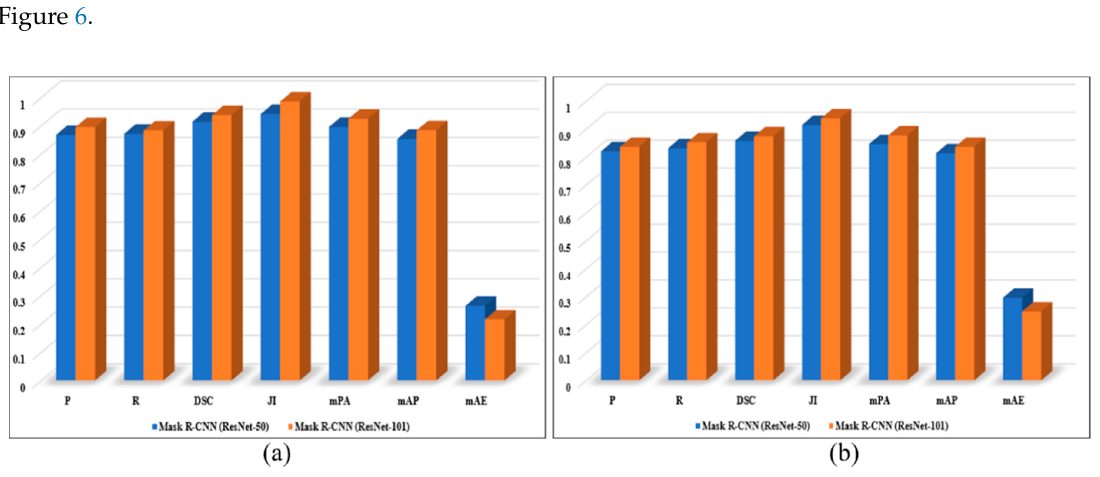
Figure 6. Quantitative performance of our proposed framework for: ( a ) stitched patches test set; ( b ) 360° images test set.